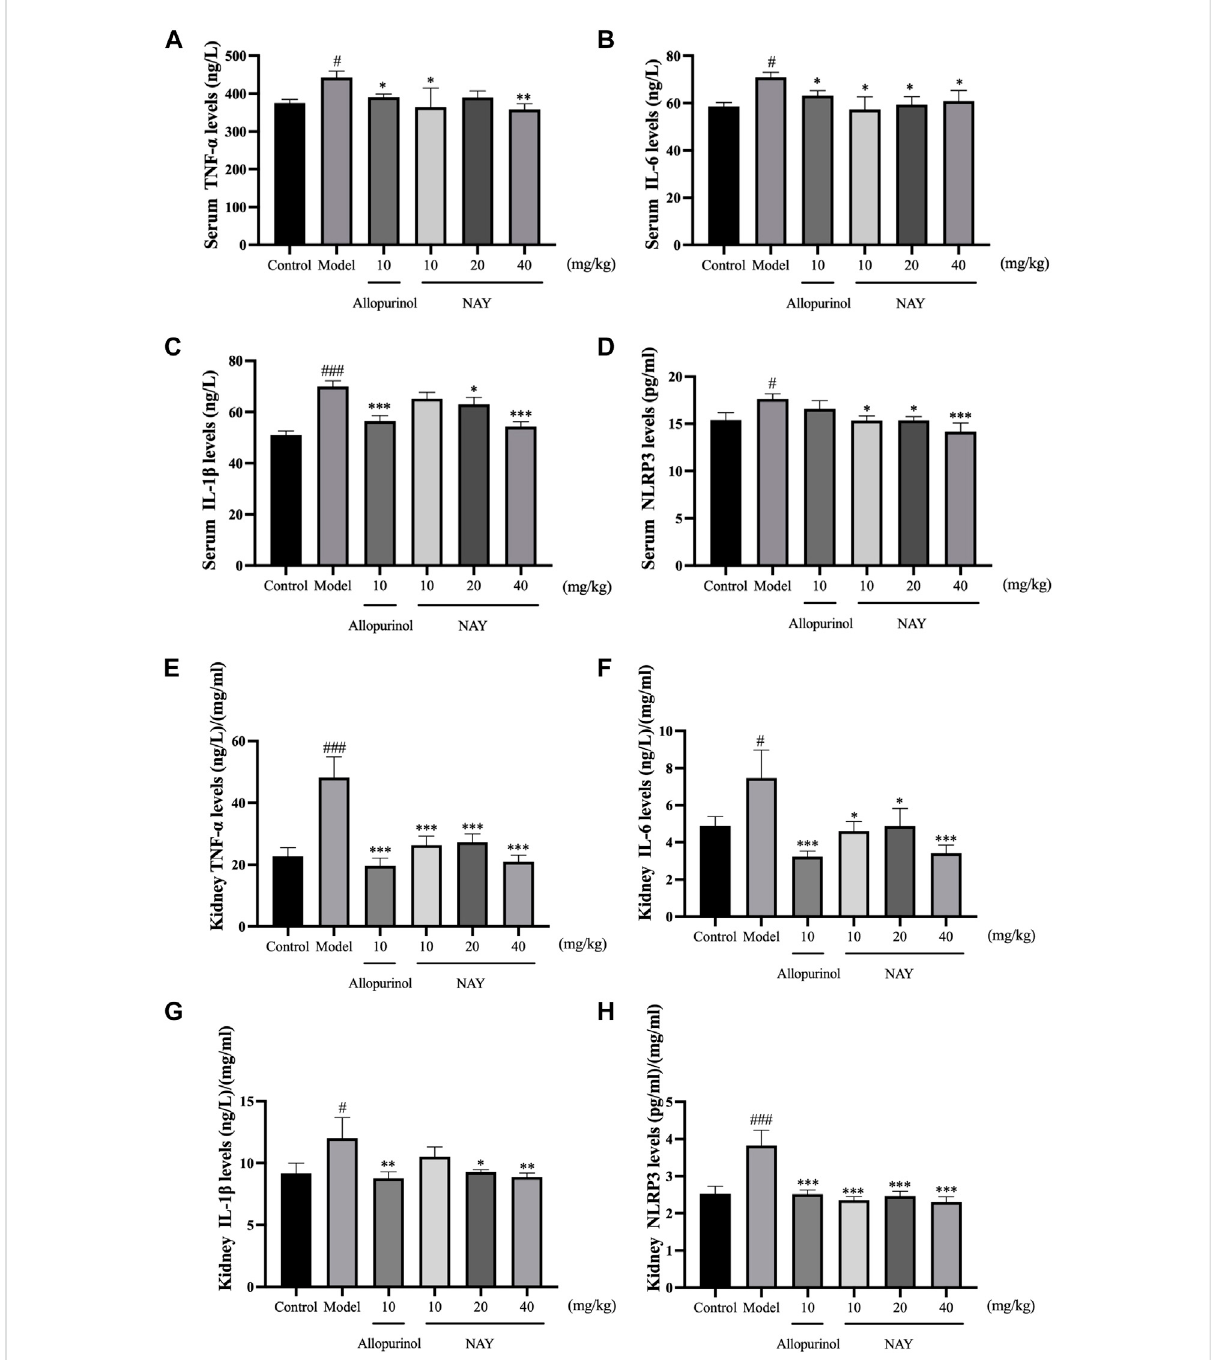
FIGURE 6 Effects of NAY on serum TNF- α (A) , IL-6 (B) , IL-1 β (C) , and NLRP3 (D) levels in hyperuricemia mice. Effects of NAY on kidney TNF- α (E) , IL-6 (F) , IL-1 β (G) , and NLRP3 (H) levels in hyperuricemia mice. (Data were expressed as mean ± S.E.M.; n = 8. Compared with the control group, # P < 0.05, ## P < 0.01, and ### P < 0.001. Compared with the model group, * P < 0.05, ** P < 0.01, and *** P <